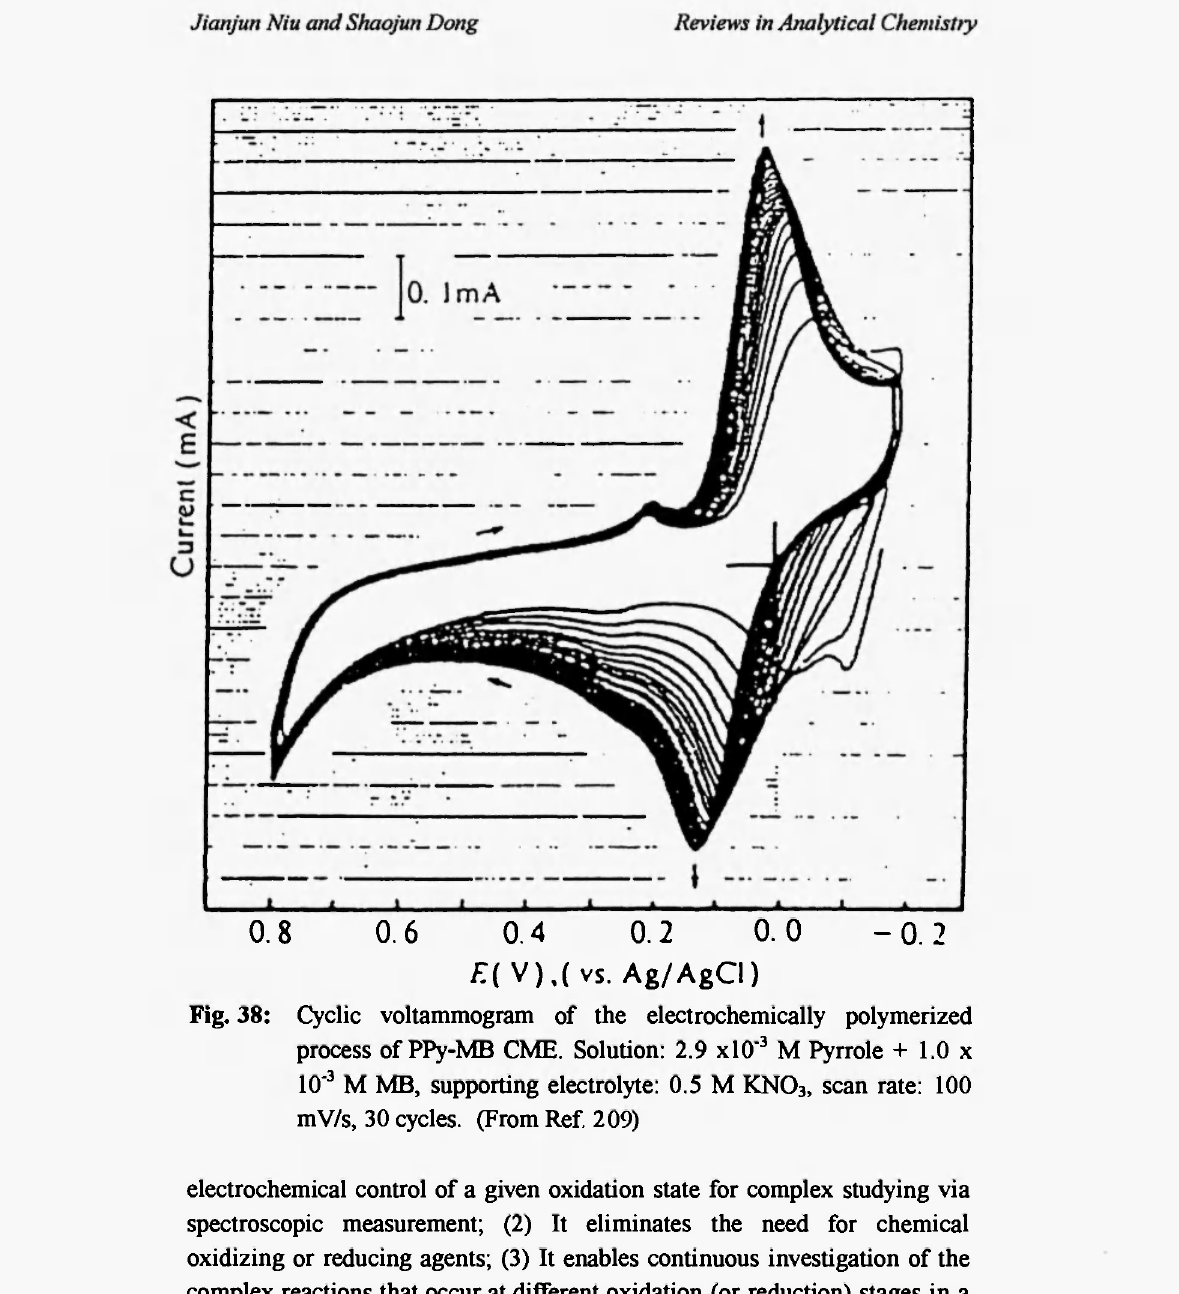
, scan rate: 100 3